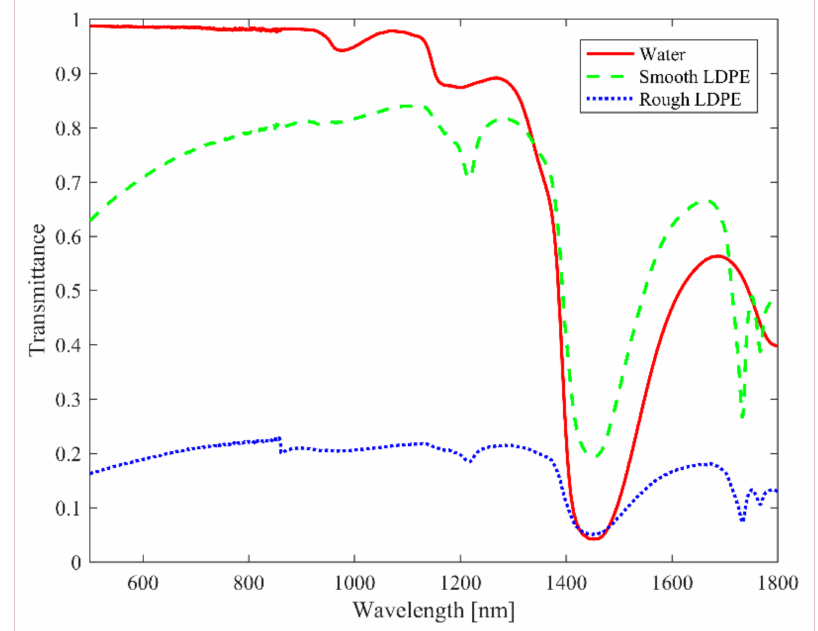
Figure 1. Vis–NIR transmittance spectra for water, smooth and rough LDPE macroplastics immersed in water